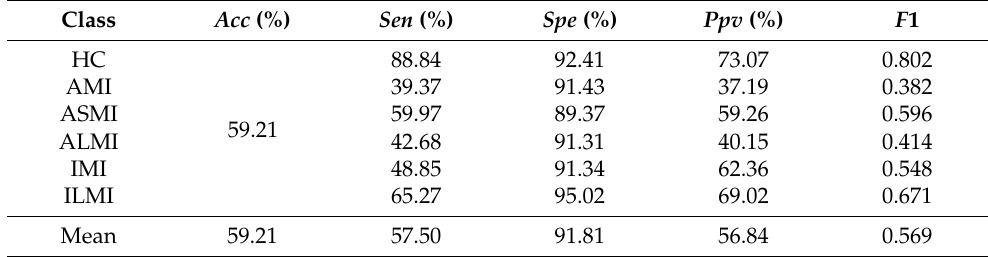
Table 1. The performance of MI localization using a single multi-class classifier on the PTB